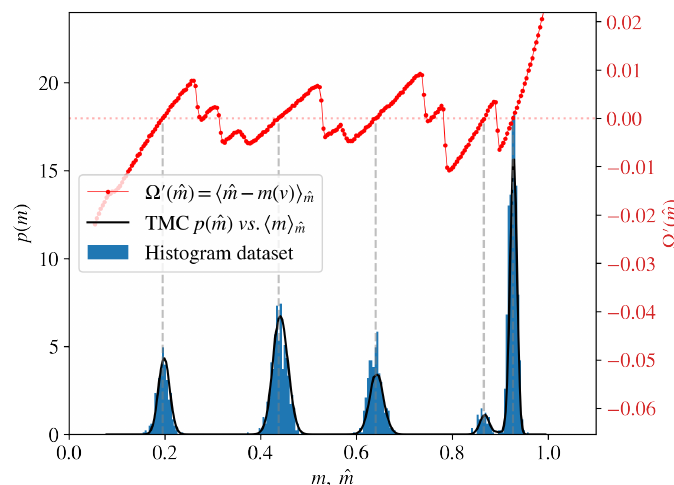
Figure 3: Reconstruction of the probability distribution profile of the dataset using TMC sampling. In red we show the derivative of the TMC effective potential, Ω ′ ( ˆ m ) , obtained from TMC simulations at fixed values of ˆ m and α = 2 · 10 4 . In black, we show the Tethered probability p ( ˆ m ) obtained from the numerical integration of Ω ( ˆ m ) plotted against 〈 m 〉 . We compare this probability with the histogram of the ˆ m projection of the dataset along ω . An almost perfect match is seen, even though the 0 two probabilities should only match in the limit α → ∞